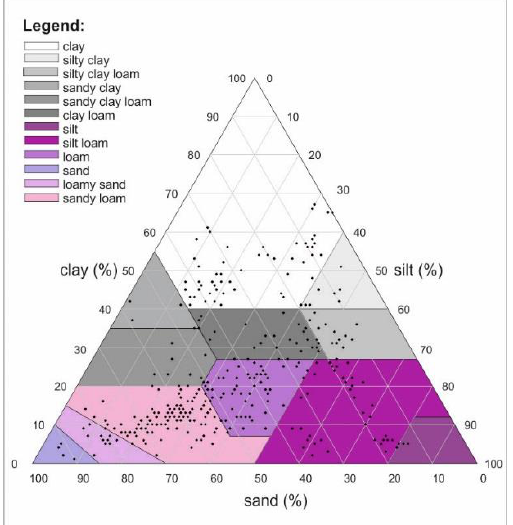
Figure 1. United States Department of Agriculture (USDA) texture classification for the investigated Sicilian soils ( n = 359).